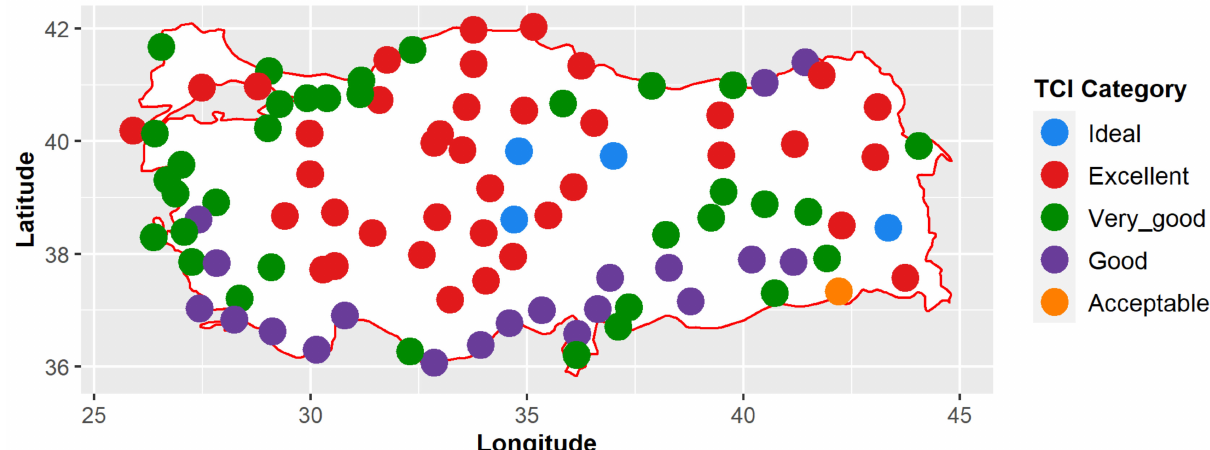
Figure 4. The TCI distribution for